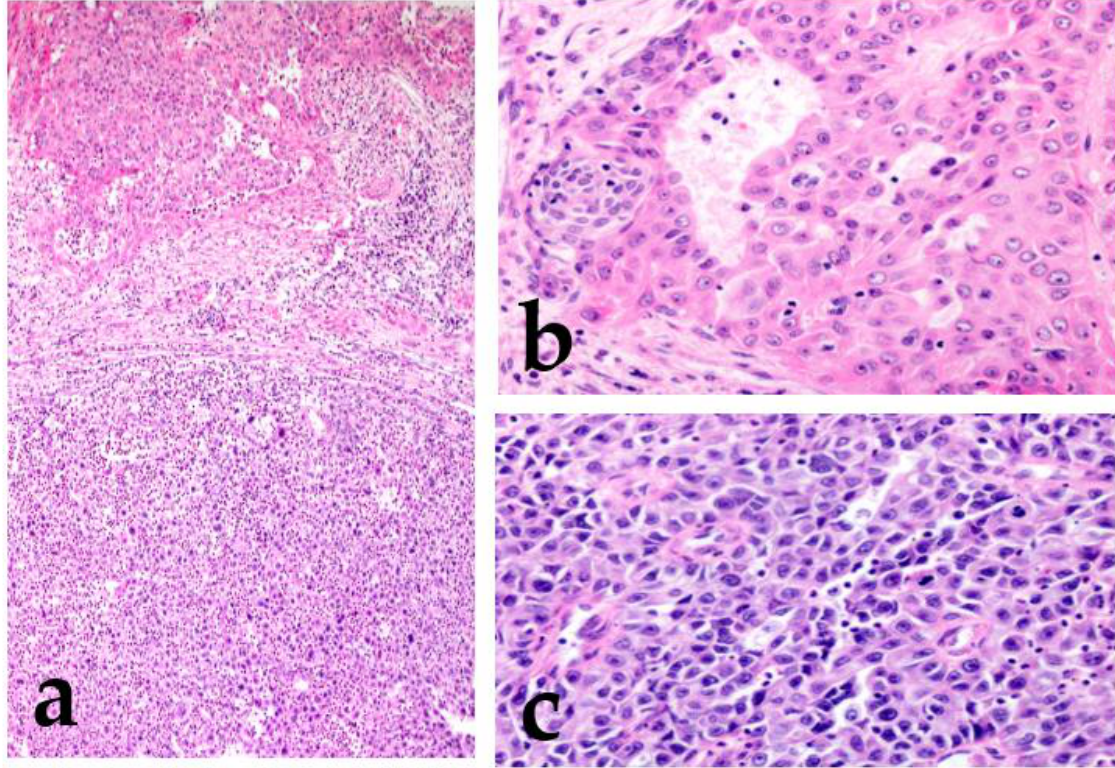
Figure 1. Mucoepidermoid carcinoma (MEC) with high-grade transformation. There is intermediate-grade MEC in the upper region, and the lower region shows high-grade transformation ( a ). Intermediate-grade MEC forms glandular or solid structures and consists mainly of intermediate cells with moderate atypia (increased nuclear size with an obvious nucleus) ( b ). The high-grade region shows undifferentiated features, and the cells lack the original morphology ( c ).